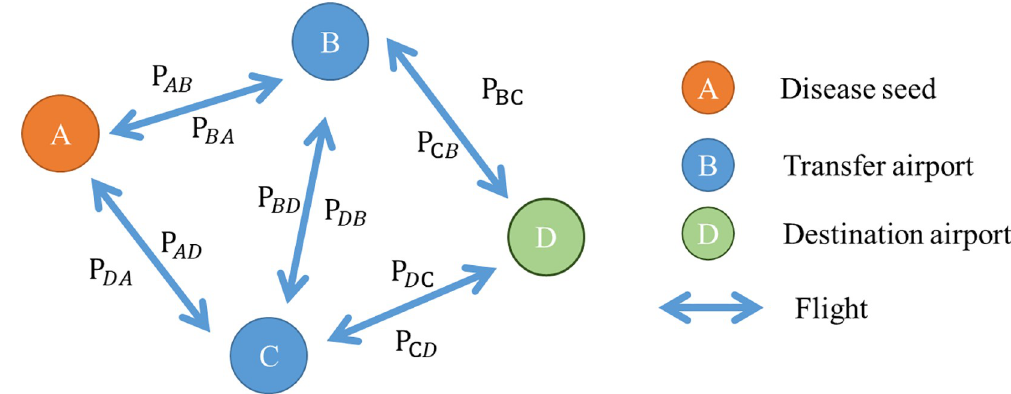
Fig 4. An example of an airport